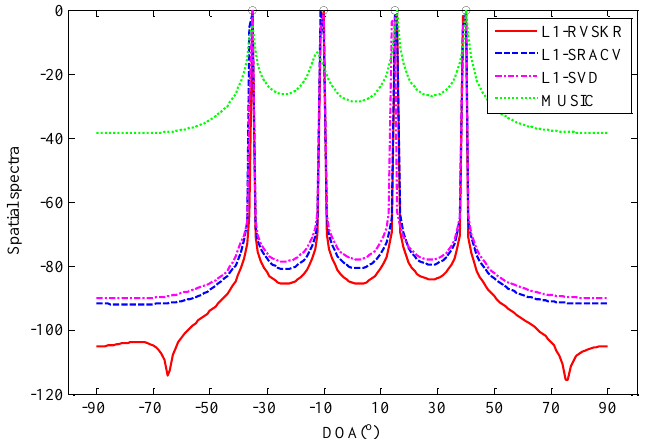
Figure 1. The spatial spectra for four signals with the number of sensors M “ 5, the number of snapshots L “ 500 and SNR = 0